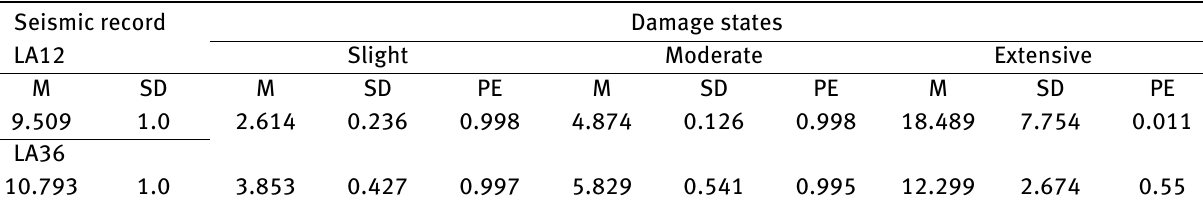
Table 4: Mean and standard deviation of the seismic records, scaling factor of the PGA at the threshold of the damage states and probabil- ity of meeting or exceeding the damage states.